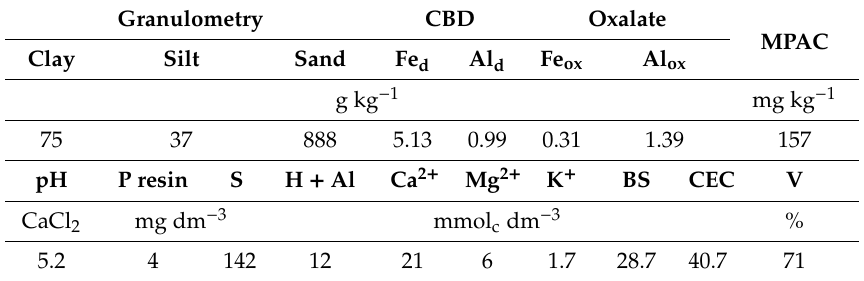
Table 3. Chemical, physical and mineralogical characteristics of the soil used in di ff usion study.